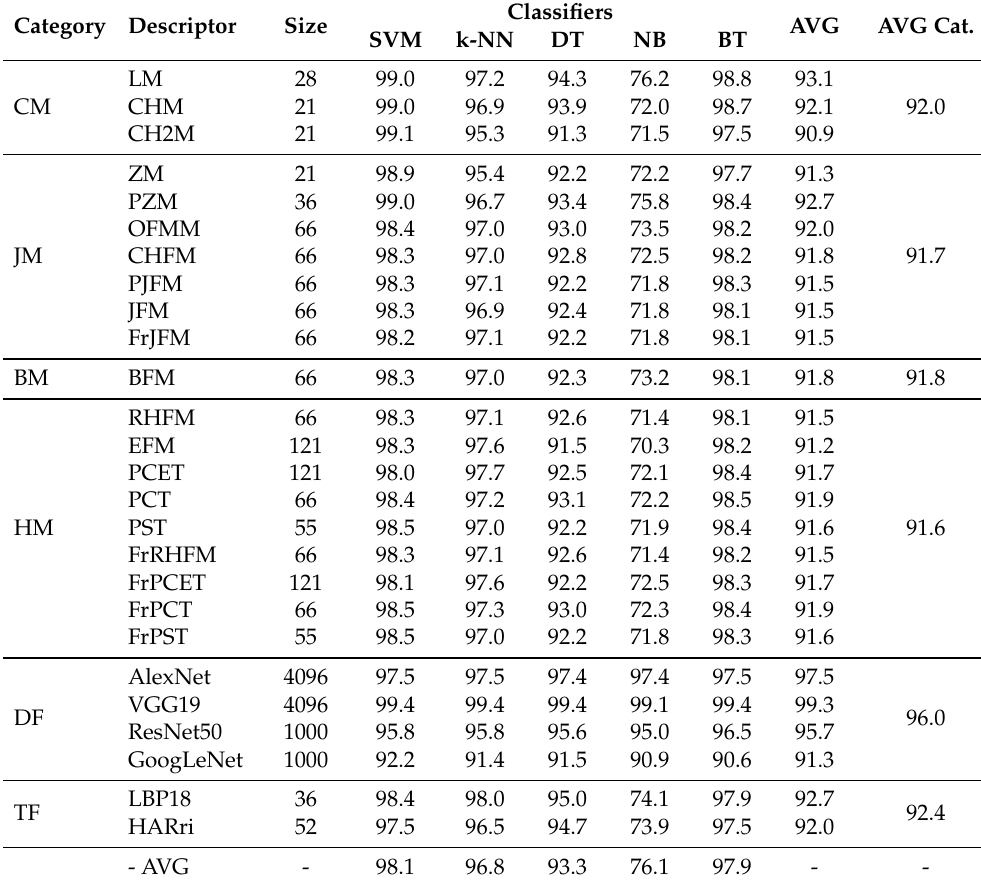
Table 6. Results obtained on the COVIDx CT-2A data set with all the analysed features, for which we report the categorisation (category column, CM—Cartesian moments, JM—Jacobian moments, BM— Bessel–Fourier moments, HM—harmonic moments, DF—deep features, and TF—texture features), the name (descriptor column), the feature size (size column), the accuracy obtained with all the tested classifiers (SVM, k-NN, DT, NB, BT columns) and the average accuracy value (AVG column). On the right (AVG cat.), we also report the average accuracy value of each category of features and on the bottom (AVG row), we report the average accuracy per